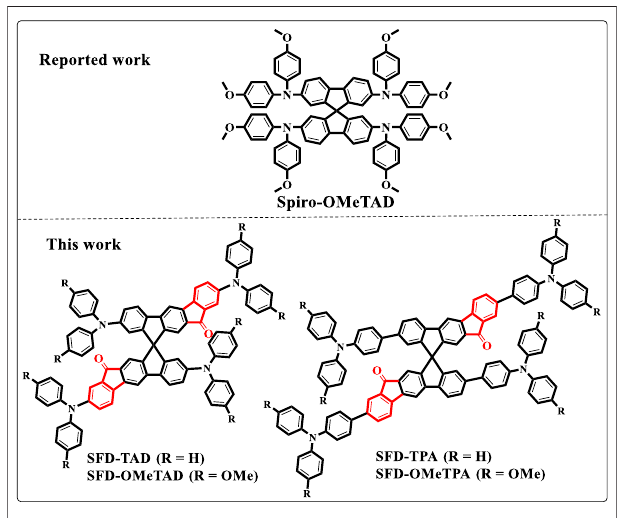
FIGURE 1 | Chemical structures of Spiro-OMeTAD, SFD-TPA, SFD- OMeTPA, SFD-TAD, and SFD-OMeTAD.